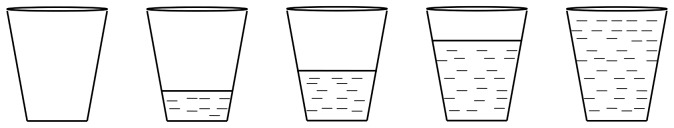
Visual representation of 5-point scale employing glasses with varying levels of water.The anchoring of the empty and full glasses varied according to the questions asked (see text).